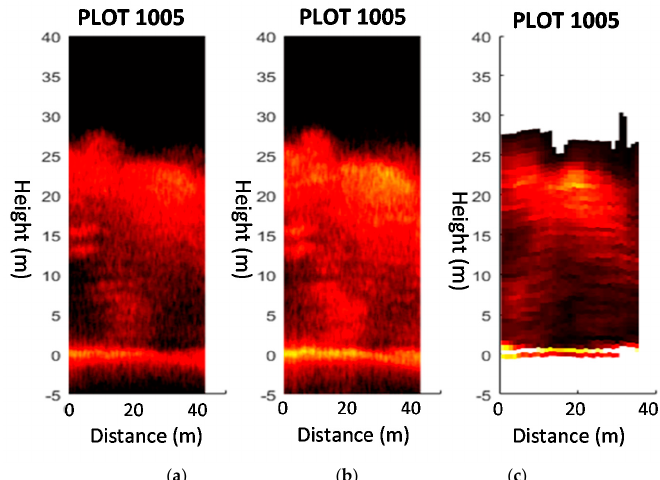
Figure 12. Tomoradar data: ( a ) HV channel; ( b ) HH channel and ( c ) The height histogram of the laser point cloud from the footprint cone as radar data.